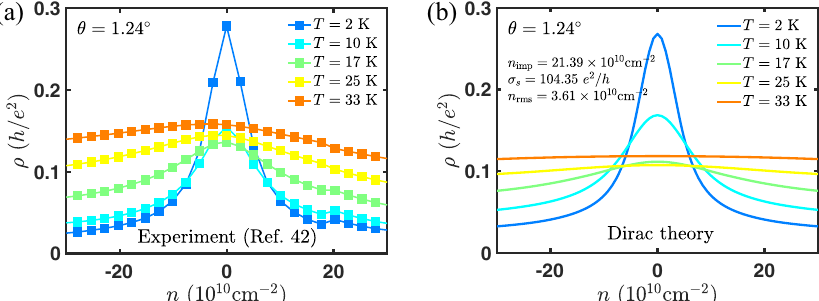
Fig. 6 The weak density dependence at high temperature and strong density dependence at a low temperature of the resistivity close to charge neutrality seen in experiment 42 is well captured within the Dirac theory of electron – (gauge) phonon scattering 40 . Experimental data (top squares) for resistivity at θ = 1.24 ∘ vs density at various temperatures ( a ) compared to the Dirac theory (bottom solid lines) of electron – phonon scattering ( b